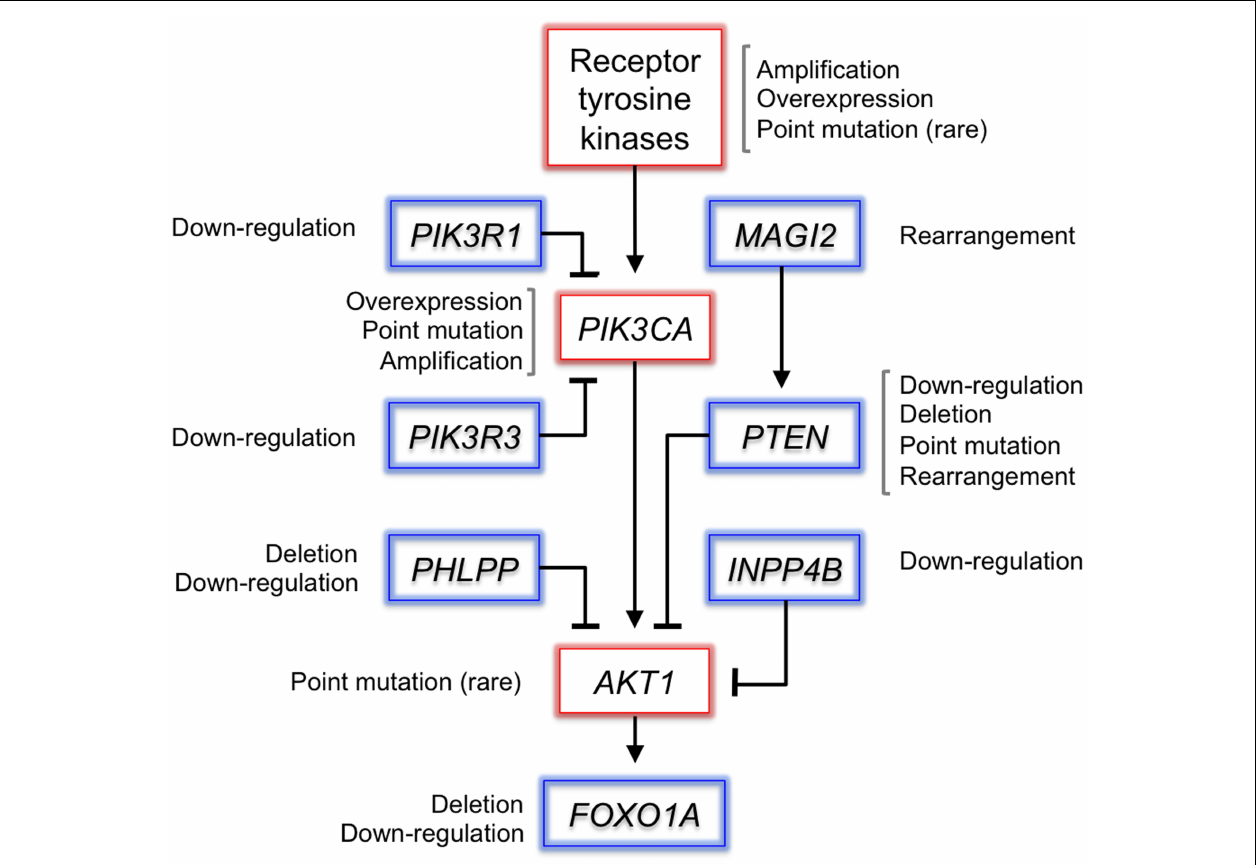
MAGI2 , which encodes a scaffolding protein that stabilizes PTEN (Wu etal., 2000; Berger etal., 2011). Recurrent deletions inactivate the FOXO1A gene, which encodes a transcription factor substrate of Akt that mediates PI3K signaling. Although rare, oncogenic mutations in the receptor tyrosine kinase EGFR or AKT1 may activate the pathway upstream or downstream of PI3K (Cai etal., 2008; Boormans etal., 2010).The expression of most pathway members is dysregulated at the transcript level as